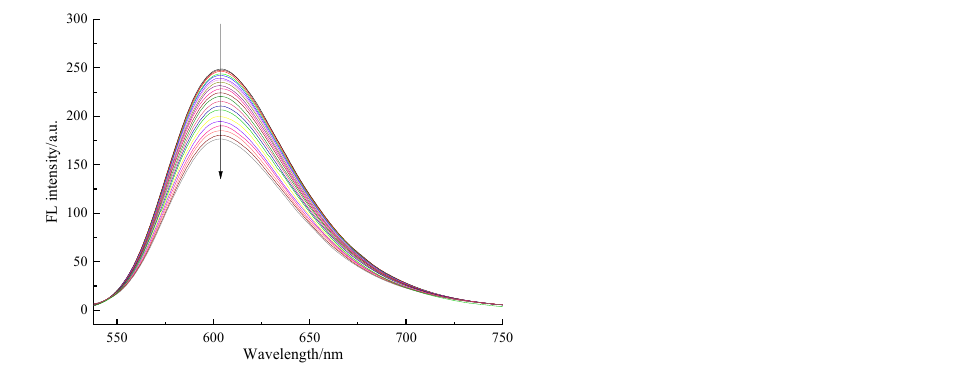
Figure 7. Emission spectra of fDNA-EB in the absence and presence of increasing amounts of L 1 at room temperature ([EB] = 2 × 10 − 5 M, [fDNA] = 1 × 10 − 4 M, and [L 1 ] = 1.5 × 10 − 5 M).